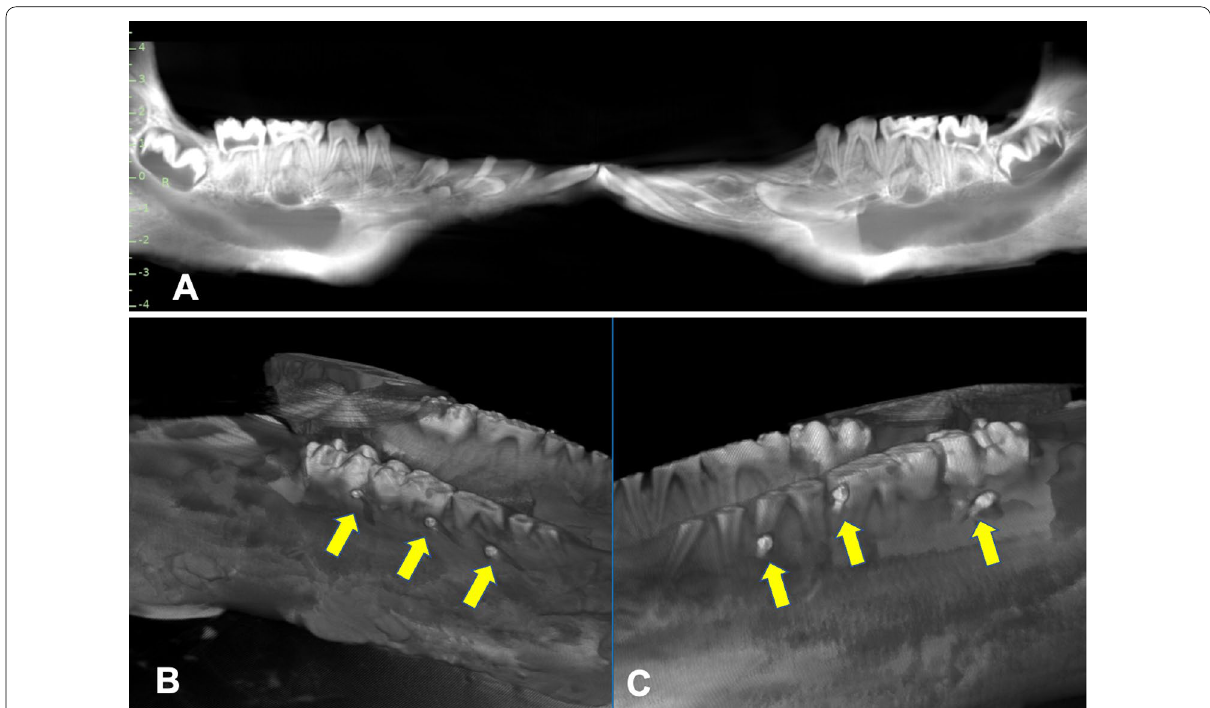
Fig. 1 Two‑dimensional radiograph A taken before the placement of miniscrews. Cone beam computed tomography (CBCT) radiograph ( B : CBCT group, C: Control) after the placement of miniscrews (arrows)